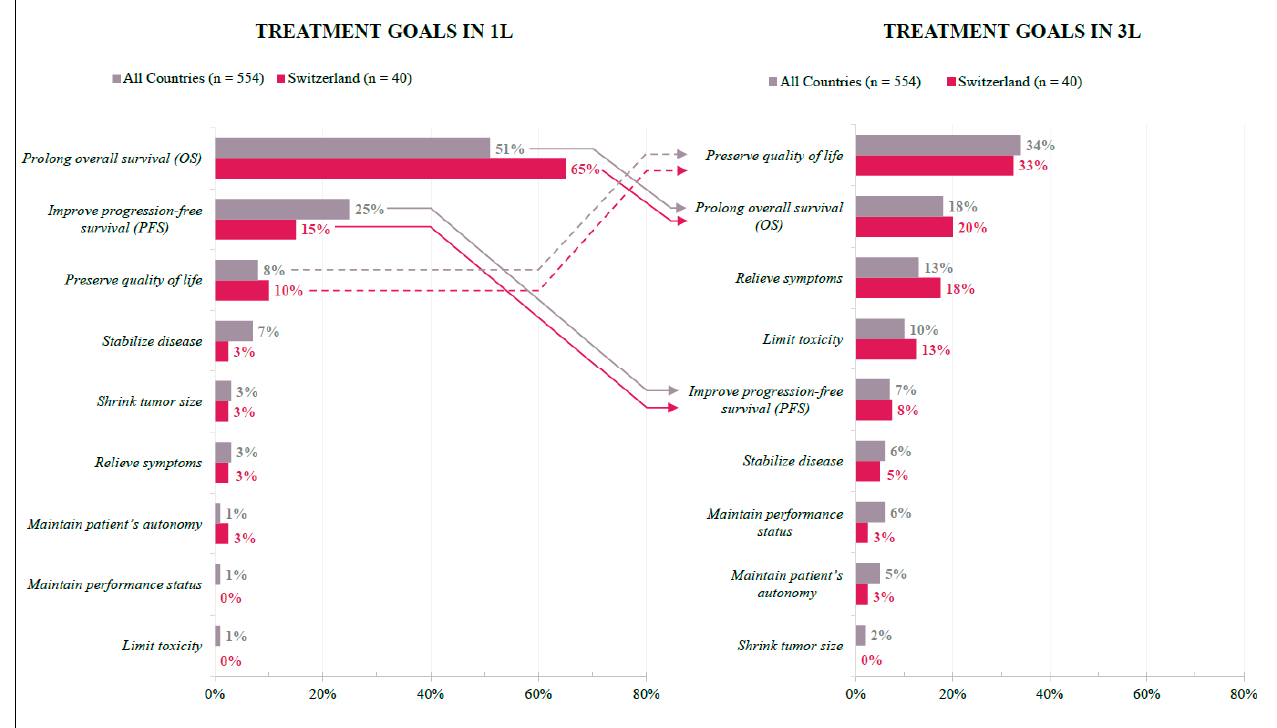
Figure 3. Treatment Goals in 1L and 3L. Preferences of Swiss (red) and International (grey) respondents expressed as percentages according to their answers. Arrows indicate change in 1L and 3L preferences; solid lines = negative change in relative (1L to 3L) position ranking; dashed lines = positive change in relative (1L to 3L) position ranking.